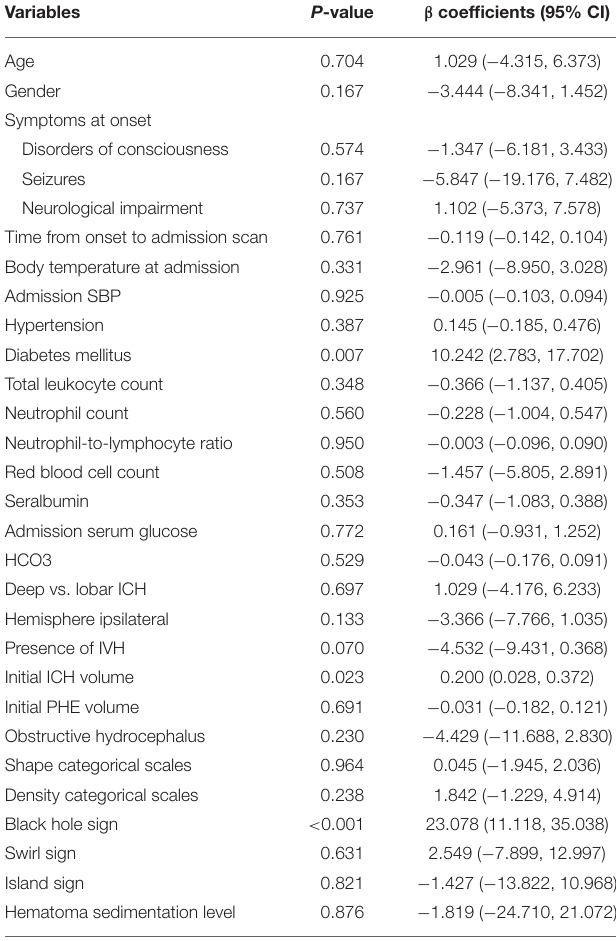
TABLE 2 | Univariate linear regression analyses of iPHE volume after intracerebral